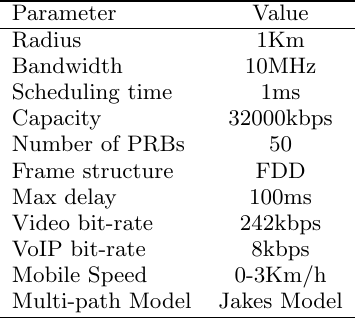
Figure 3: Packet Drop Ratio